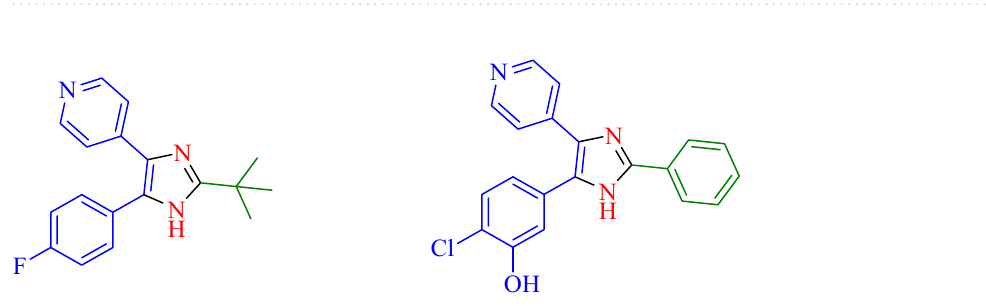
Figure 2. Some biological heterocyclic compounds containing imidazole